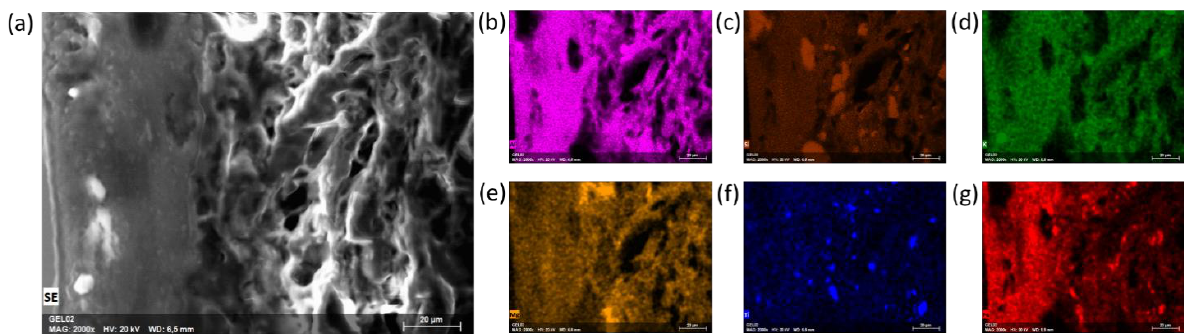
Figure 8. ( a ) SEM image of sample GEL02; maps of ( b ) Al, ( c ) Si, ( d ) K, ( e ) Mg, ( f ) Ti and ( g ) Fe.